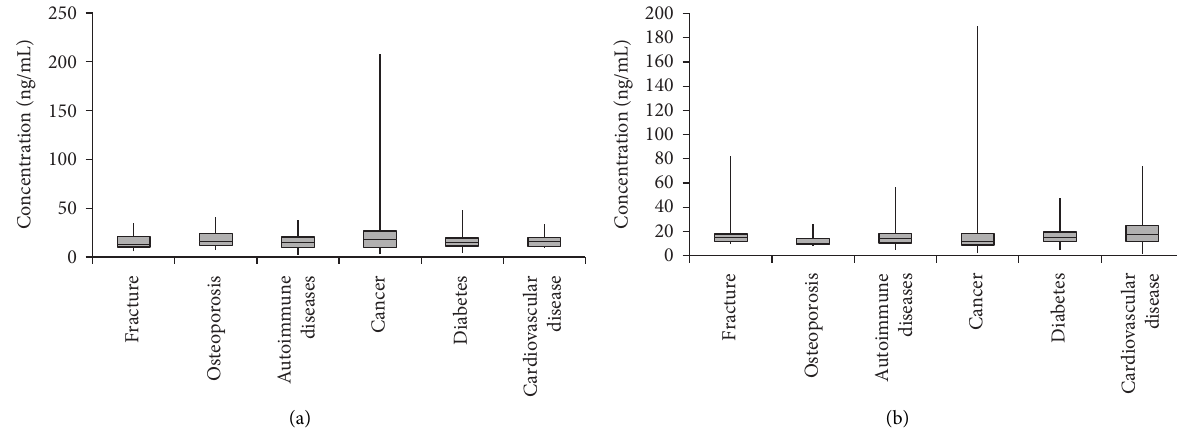
Figure 8: BGP concentration in postmenopausal women (a) and BGP concentration in men (b)